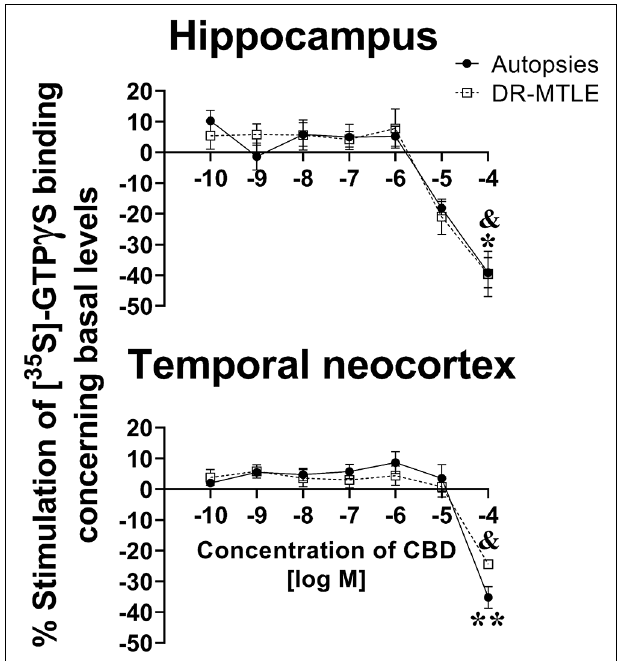
FIGURE 2 | Effect of increasing concentrations of CBD on [ 35 S]-GTP γ S binding in cell membranes obtained from the hippocampus (top panels) and the temporal neocortex (bottom panels) of autopsies and patients with drug-resistant MTLE. Values are expressed as the mean ± SEM. * p < 0.05, ** p < 0.01 (autopsies vs. baseline values); & p < 0.05 MTLE vs. baseline values.